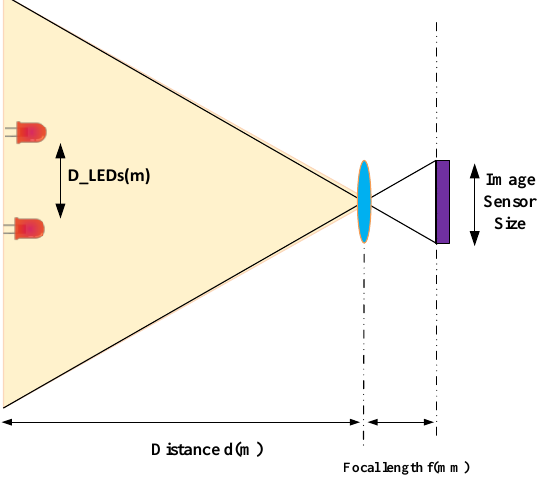
Figure 13. Relationship between the camera focal length and communication distance.